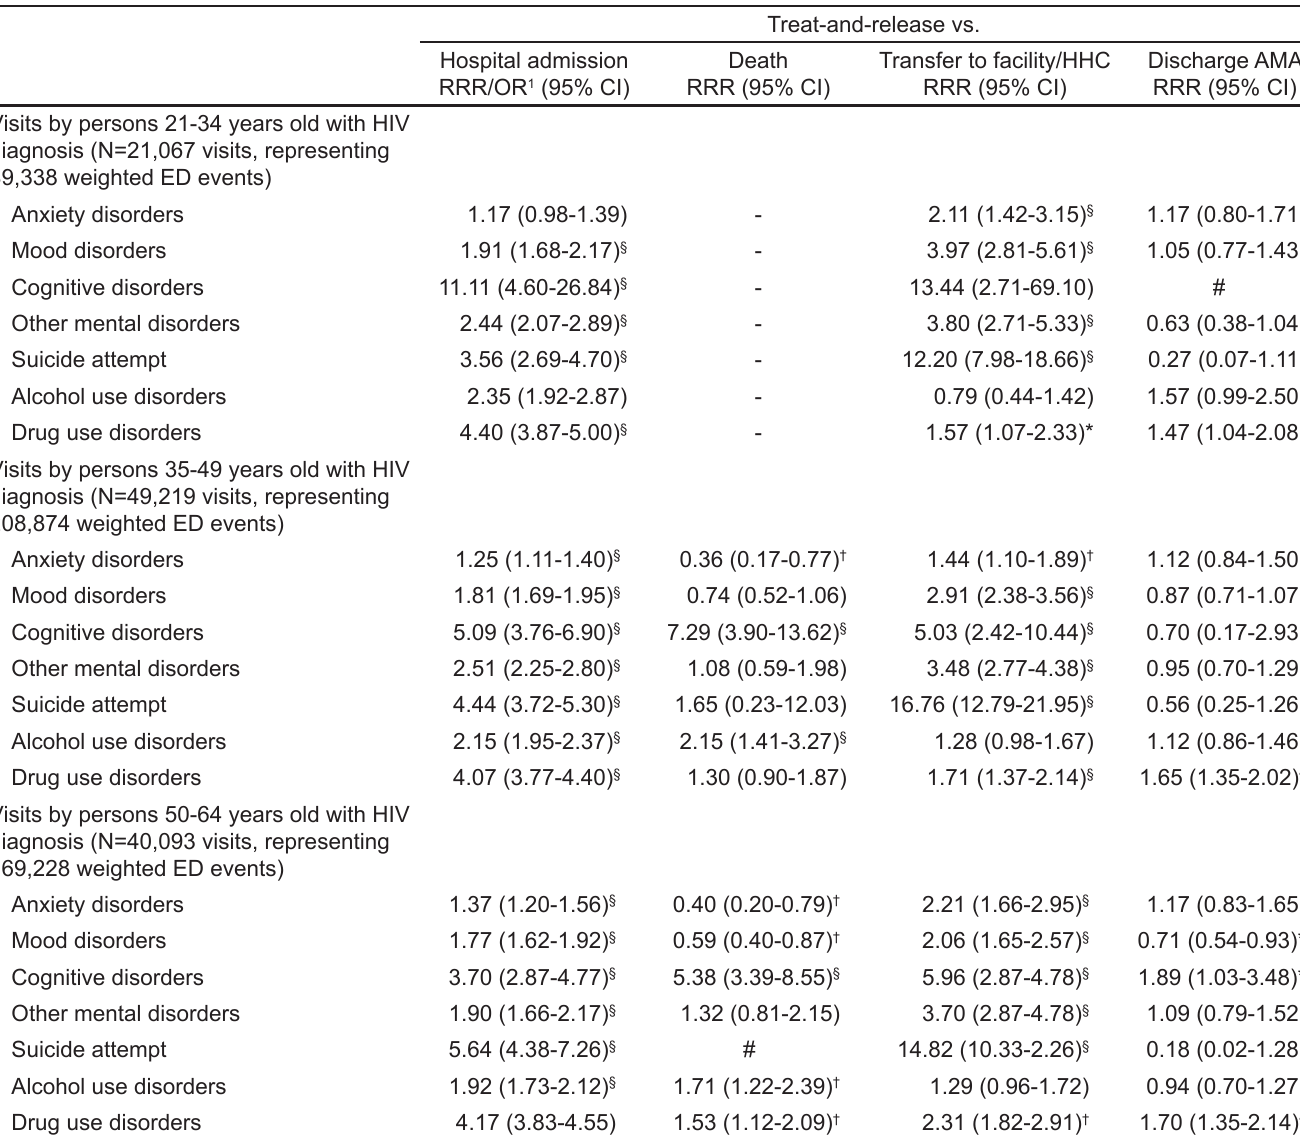
Table 5. Associations of mental health and substance-use disorders with ED outcomes within each age group: Relative risk ratios (RRR) or odds ratios (OR) and 95% confidence intervals (CI) from multinomial or binary logistic regression